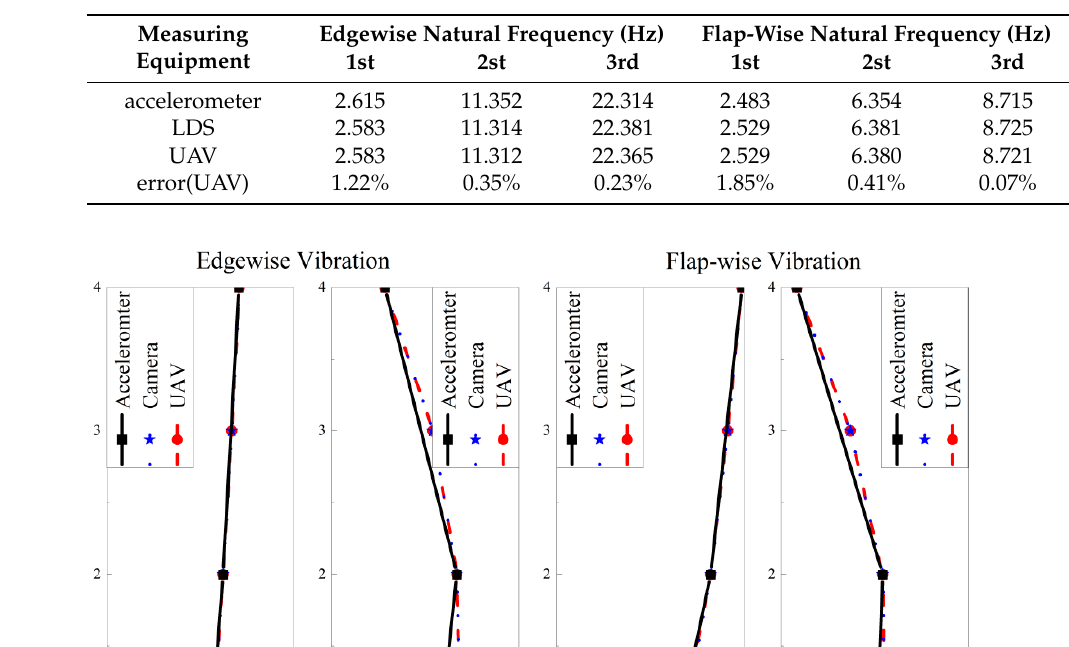
Table 4. Comparison of frequency domain recognition effects of different equipment.